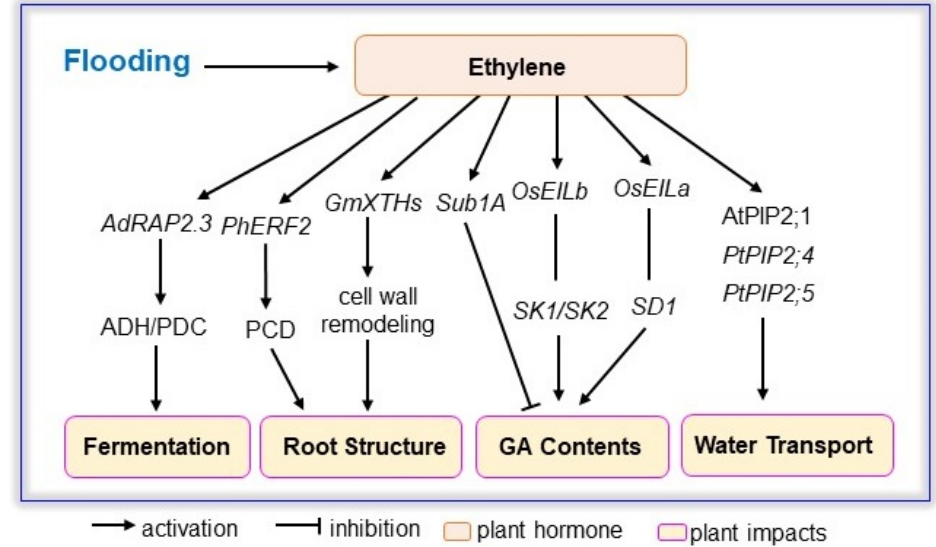
Figure 1. Ethylene signaling involved in plant response to flooding. Flooding increases ethylene amount and subsequently induces RAP2.3 , ERF2 , Sub1A , EILa/b , PIP2;1/2;4/2;5 to modulate fermenta- tion, root architecture, GA homeostasis, and water transport capacity in Arabidopsis, rice, soybean, Actinidia deliciosa , Petunia (Petunia × hybrida) , and Populus tremuloides . ADH, alcohol dehydrogenase; ERF2, ethylene response factor2; EIL, ethylene insensitive like ; GA, gibberellic acid; PCD, programmed cell death; PDC, pyruvate decarboxylase; PIP, plasma membrane intrinsic protein; RAP2.3, related to apetala 2.3 ; SD1, SEMI-DWARF1; SK1/SK2 , SNORKEL1/SNORKEL2; Sub1A, Submergence1A; XTH, xyloglucan endotransglycosylases/hydrolases